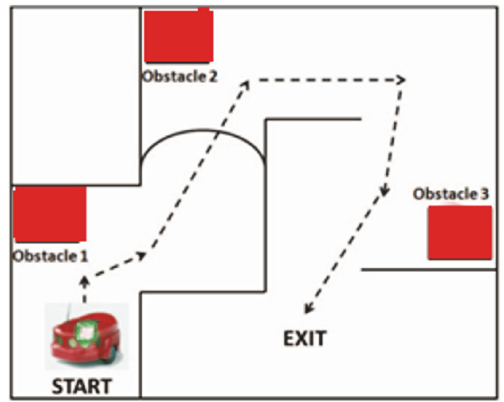
Figure 2: Neural Network with backpropagation approach to control P3DX navigation from the start and exit of maze (source